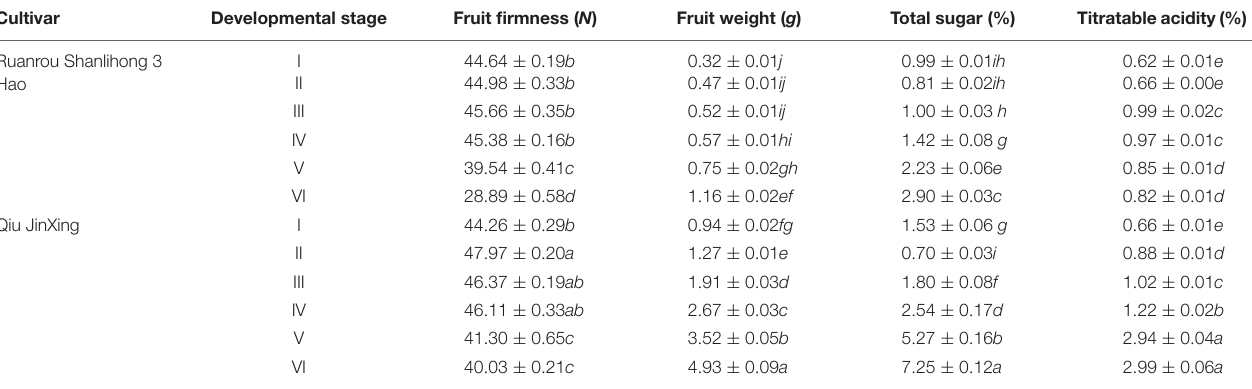
TABLE 1 | Variations in fruit firmness, weight, total sugar and titratable acidity in ‘Ruanrou Shanlihong 3 Hao’ and ‘Qiu JinXing’ fruits. Cultivar Developmental stage Fruit firmness ( N ) Fruit weight ( g ) Total sugar (%)